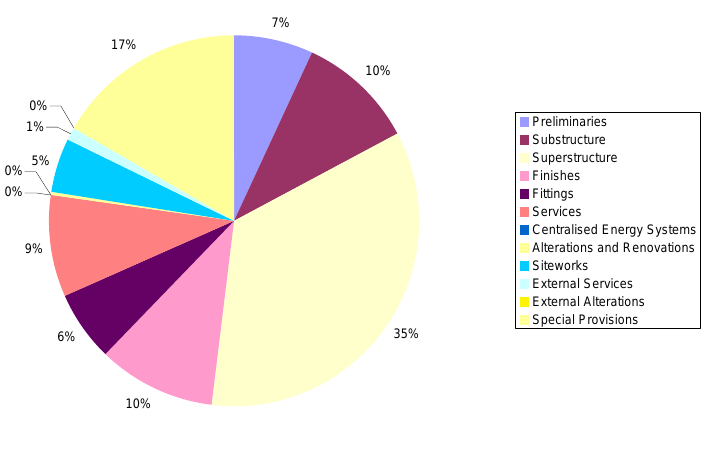
Figure 1: Initial Embodied Energy Distribution by Elemental Group